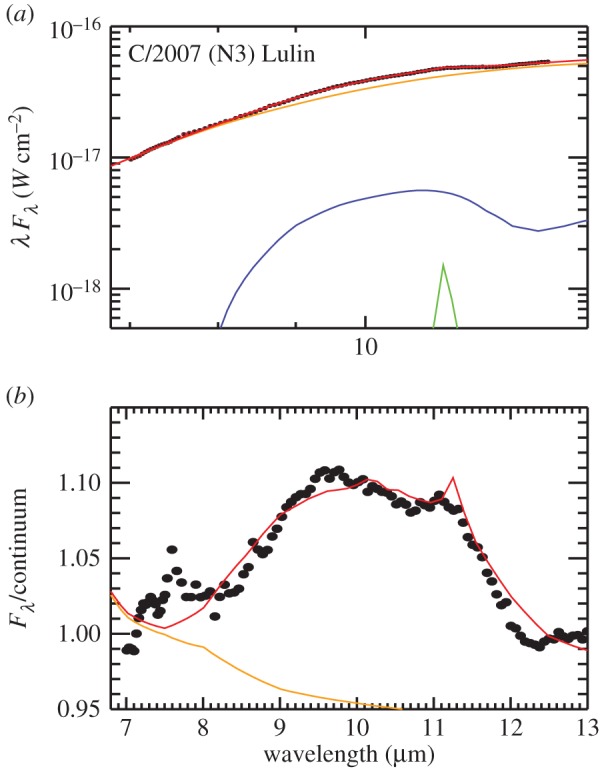
(a) Spitzer IR spectral energy distribution (SED, log(λFλ) versus log(λ)) of comet C/2007 N3 (Lulin) with weak spectral features, which indicates its coma has micrometre-sized grains and low porosity aggregates. (b) Silicate feature strength (Fλ/continuum). Comet Lulin has a very weak silicate feature and compact porous particles; polarization values also reveal compact porous aggregates [148] (reproduced with permission from [148], fig. 8. Copyright © AAS). (Online version in colour.)